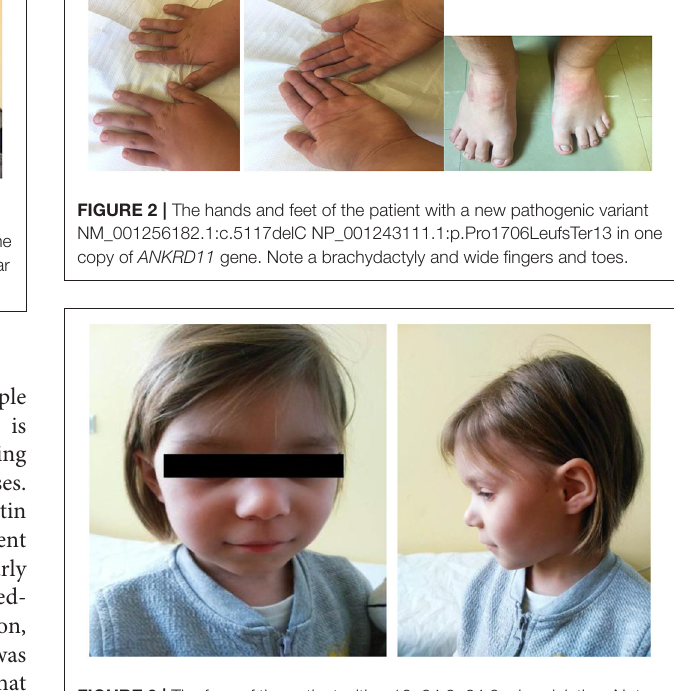
FIGURE 3 | The face of the patient with a 16q24.2q24.3 microdeletion. Note a characteristic facial features: wide eyebrows, bulbous nose with prominent nasal bridge, thin upper lip, long philtrum.